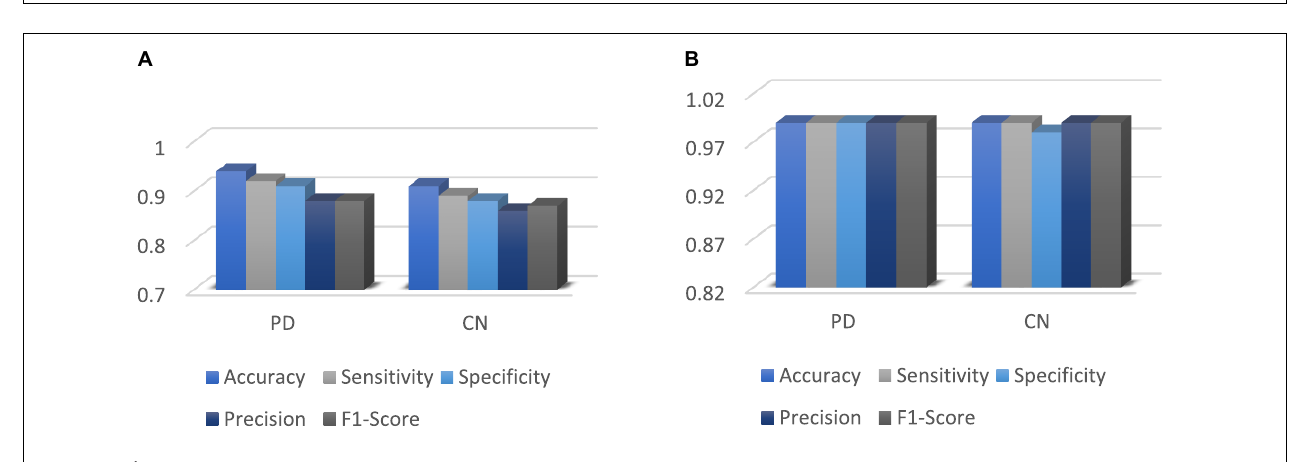
FIGURE 12 | (A) Without augmented images; (B) with augmented